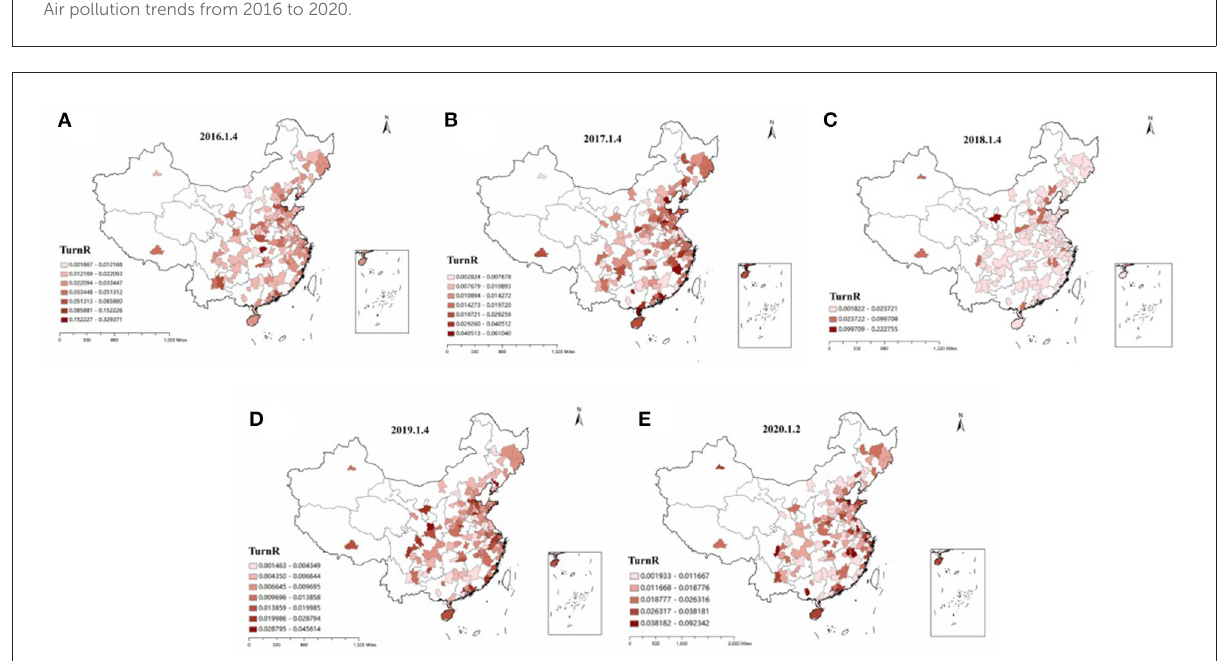
FIGURE3 (A–E) Spatio-temporal evolution of corporate stock liquidity in different regions of